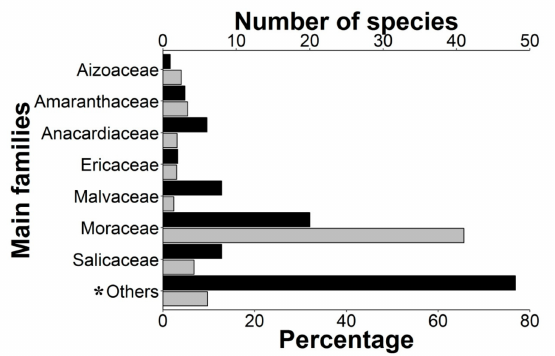
Figure 3. Percentage of events (grey bars) and the number of plant species (black bars) within the main plant families. * Category “Others” includes the plant families with a lower percentage of events (<2.4%): Apocynaceae, Bignoniaceae, Bursareceae, Cactaceae, Cannabaceae, Combretaceae, Compositae, Cupressaceae, Dilleniaceae, Elaeocarpaceae, Euphorbiaceae, Gentianaceae, Lamiaceae, Leguminosae, Malpighiaceae, Melastomataceae, Meliaceae, Monimiaceae, Myrtaceae, Phytolaccaceae, Poaceae, Primulaceae, Rosaceae, Rubiaceae, Sapindaceae, Solanaceae, Urticaceae, and